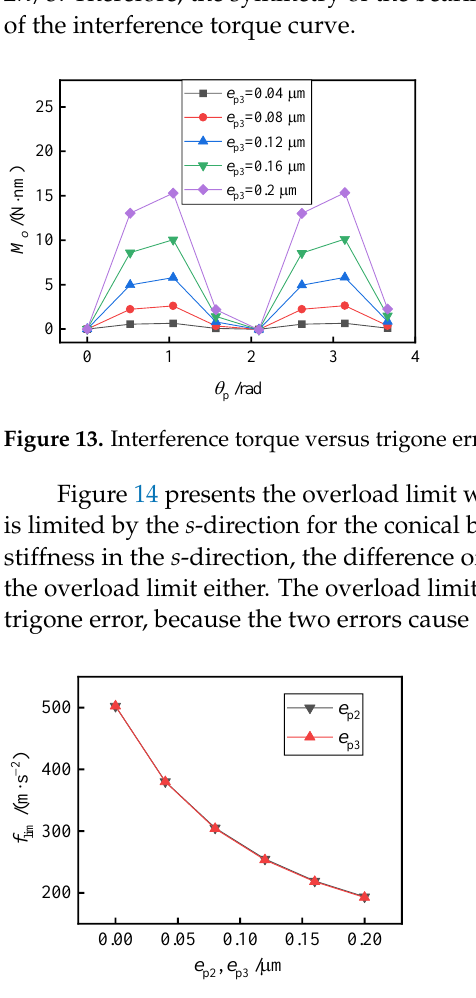
Figure 14. Overload limit versus oval error and trigone error.